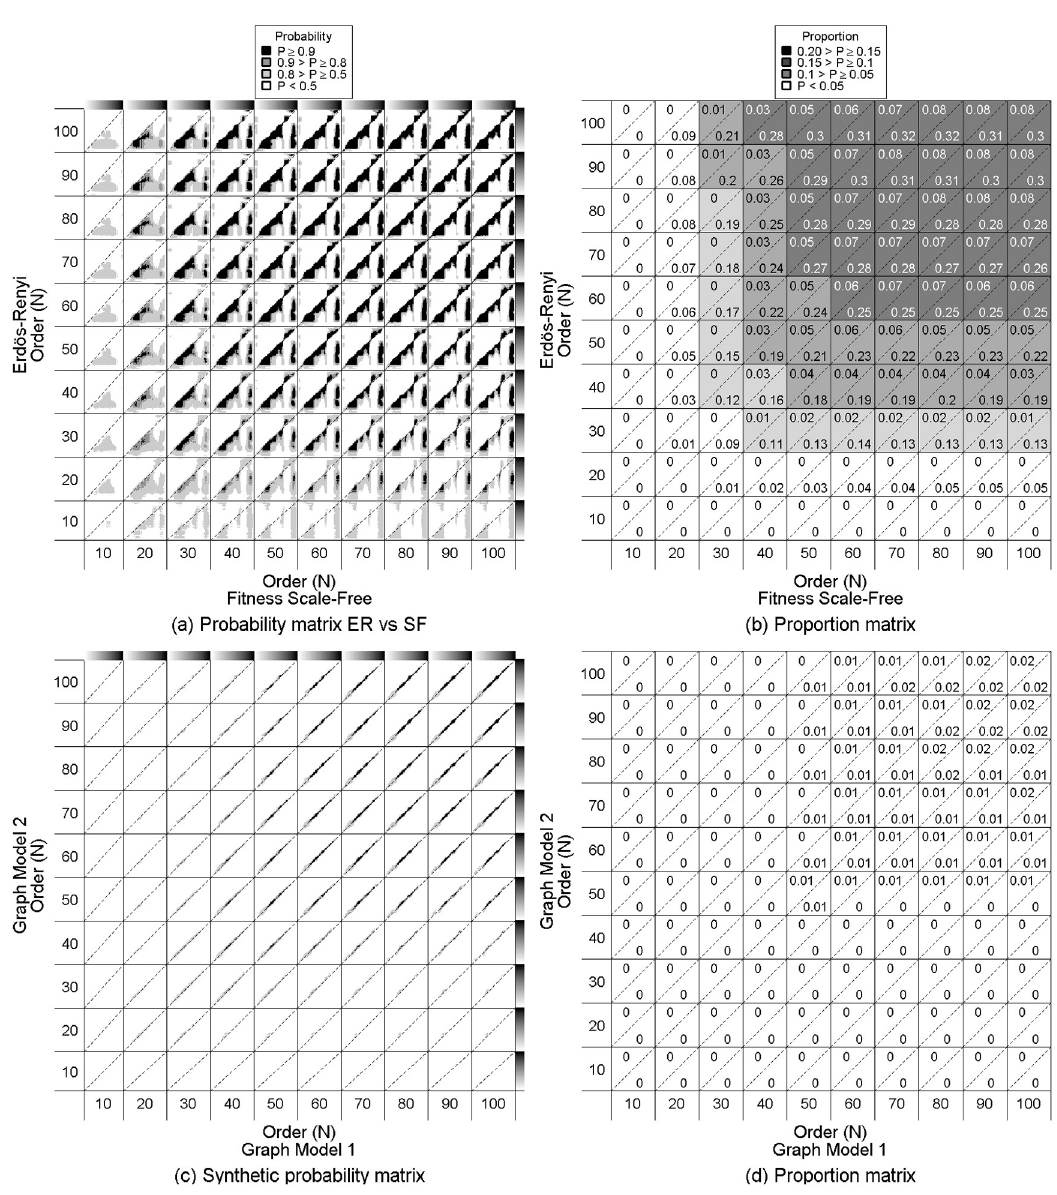
that D > max ð D ; D Þ M 1 ; M 2 M 1 ð N ; d Þ ; M 2 ð N 0 ; d 0 Þ M 1 ð N ; d Þ ; M 1 ð N 0 ; d 0 Þ M 2 ð N ; d Þ ; M 2 ð N 0 ; d 0 Þ